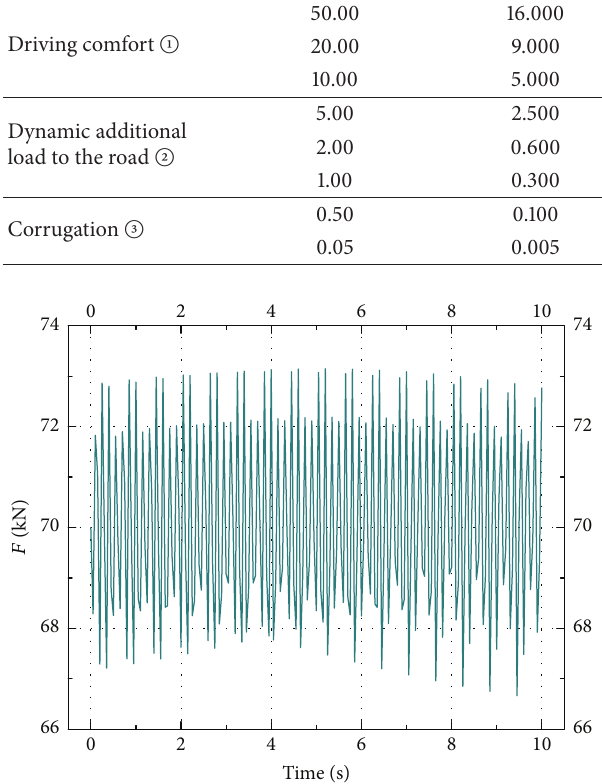
Figure 6: Vibrating load versus time